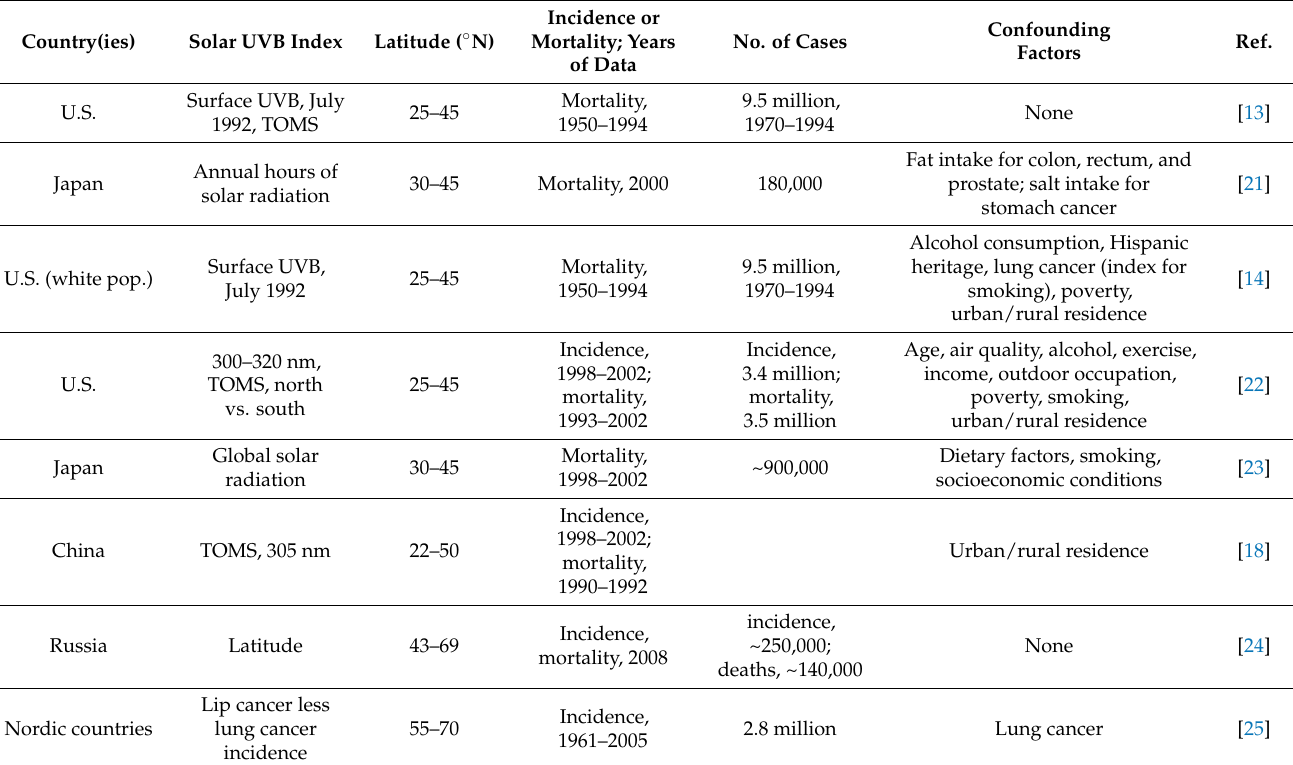
Table 1. Characteristics of large single-country ecological studies of cancer incidence or mortality rates with respect to solar UVB